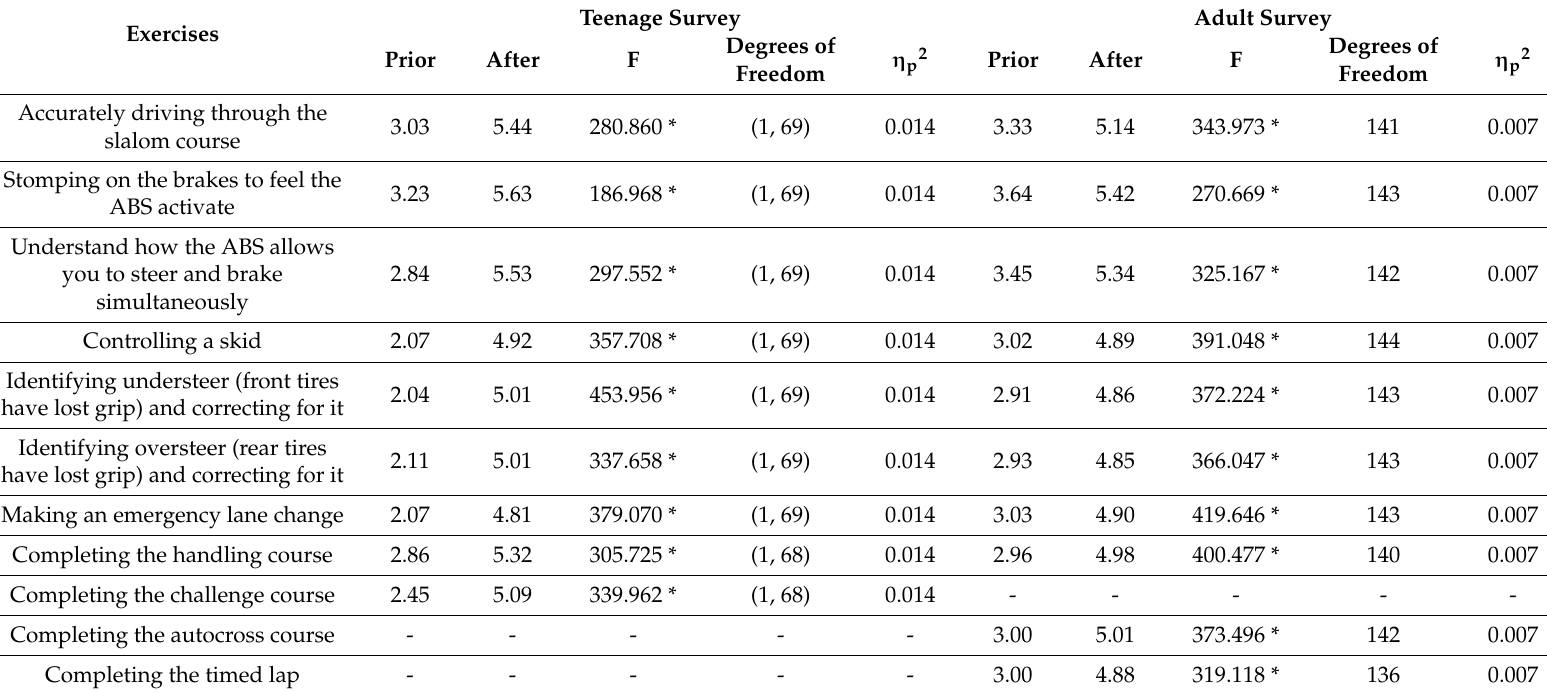
Table 6. Teenage and adult survey participants’ average ratings of their competency to perform the class exercises prior to and directly after the class. The asterisk designates significant di ff erences ( p <